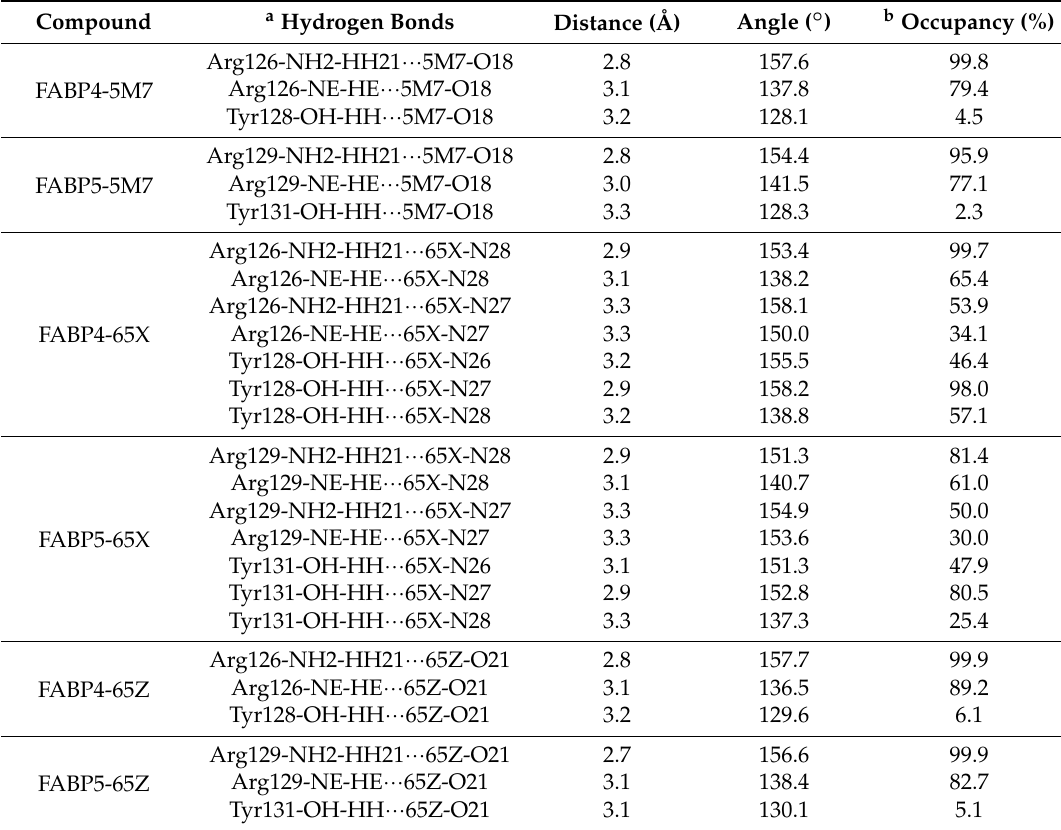
Table 2. Main hydrogen bonding interactions formed between inhibitors and FABP4 and FABP5.